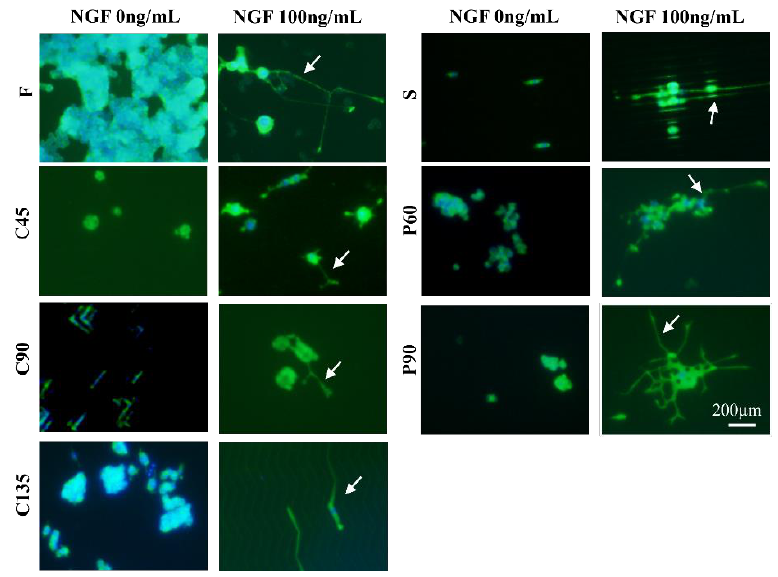
Figure 2. Fluorescence images of F-actin expression of PC12 cells under different conditions. Green, F-actin; blue, cell nucleus; NGF:100 ng/mL; Scale bar = 200 µm.